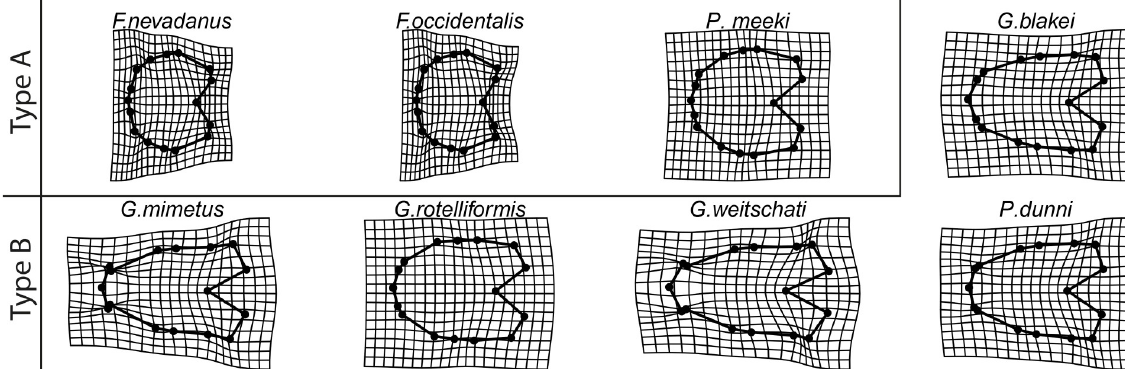
Fig 6. TPS spline of mean shape of whorl 5.5 of all species in this study (grey) plotted against the mean shape of whorl 5.5 of the respective species (black).